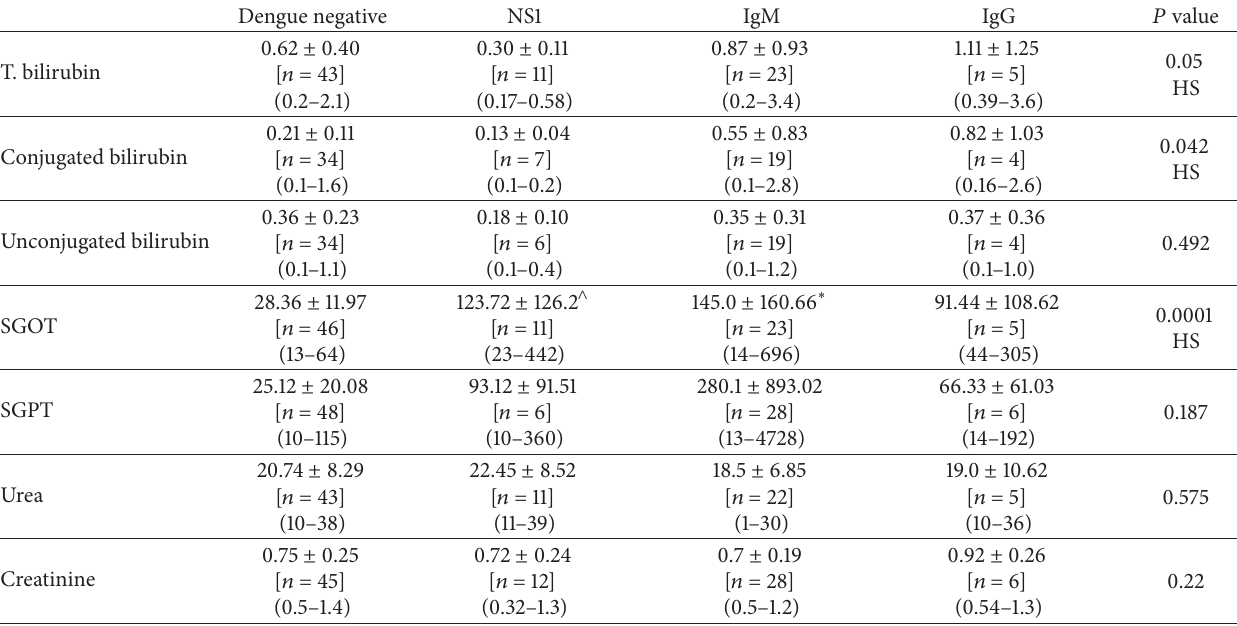
Table 5: Alterations in biochemical parameters by comparing with different stages of